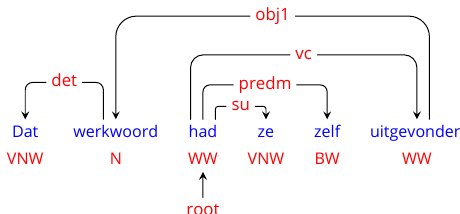
A dependency structure derived from the tree in Figure 1. The obj1 arc makes this